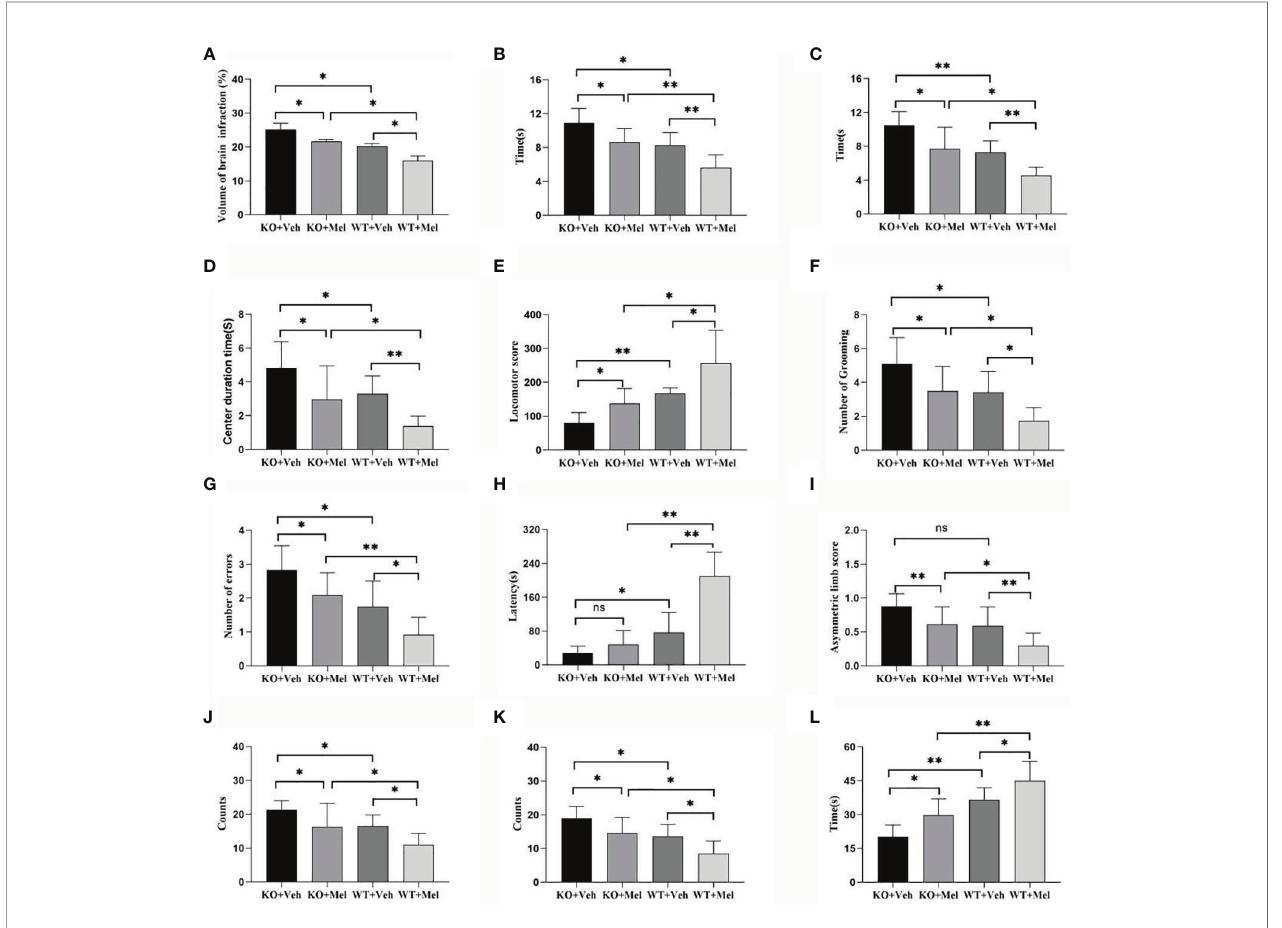
FIGURE 4 | Behavioral test in wild-type mice with HI injury treated with vehicle or melatonin as well as knockout mice with HI injury receiving vehicle and melatonin treatments as indicated. (A) TTC staining; (B) Negative geotaxis re fl ex test; (C) Cliff avoidance re fl ex test; (D) Open fi eld test-center duration time; (E) Open fi eld test- locomotor score; (F) Open fi eld test-number of grooming; (G) Step through test-number of errors; (H) Step through test-latency avoidance period; (I) Cylinder test; (J) Foot fault test-forelimb foot fault test; (K) Foot fault test-hindlimb foot fault test; (L) Seizure threshold. [Two-way ANOVA, Bonferroni post hoc test (details are shown in